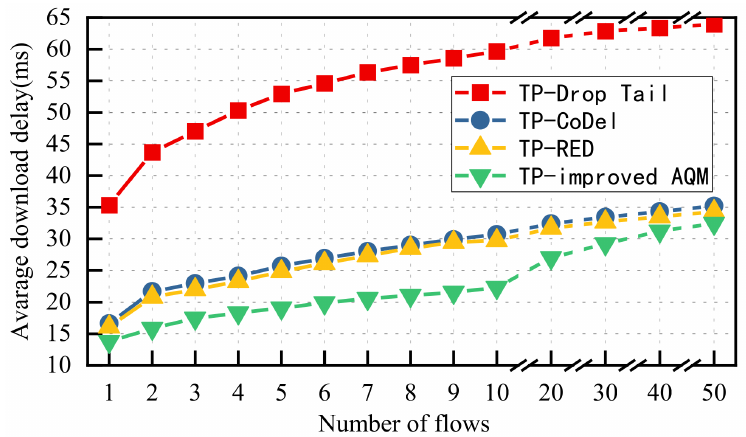
Figure 14. The average content download delay under different numbers of ICN flows.